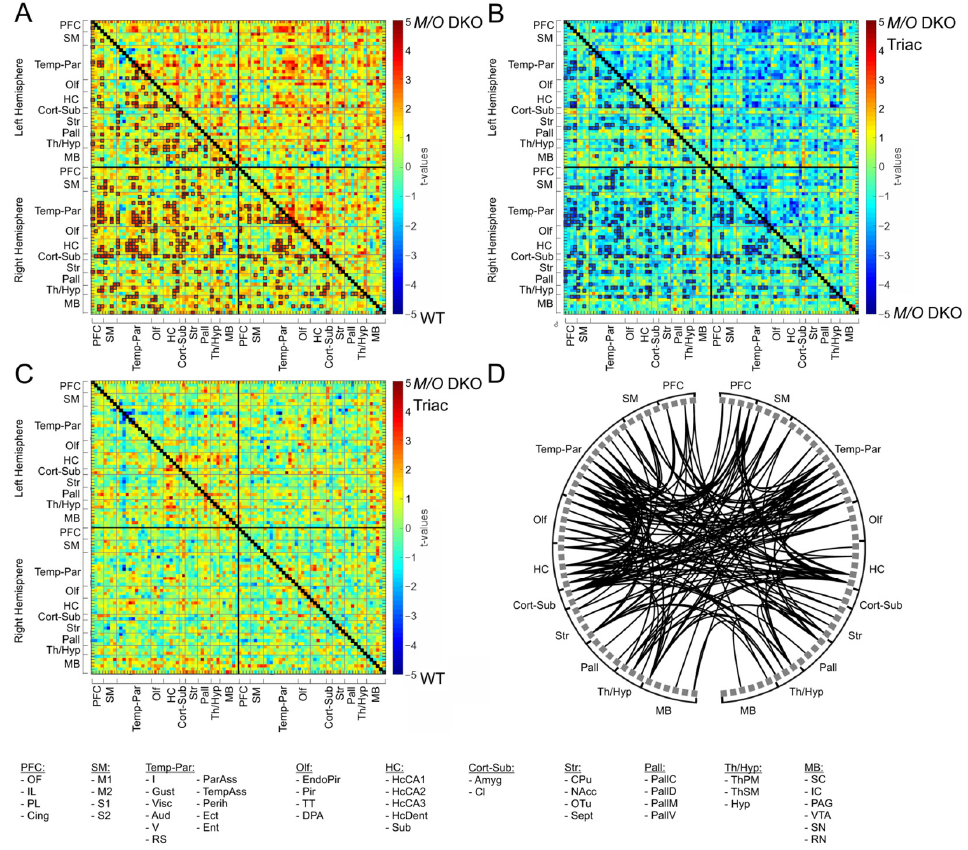
on prefrontal (PFC), sensorimotor (SM), and temporo-parietal cortices (Temp-Par) as well as striatal and hippocampal regions (HC), and compromised about one ninth of all connections (494 of 4371 connections).